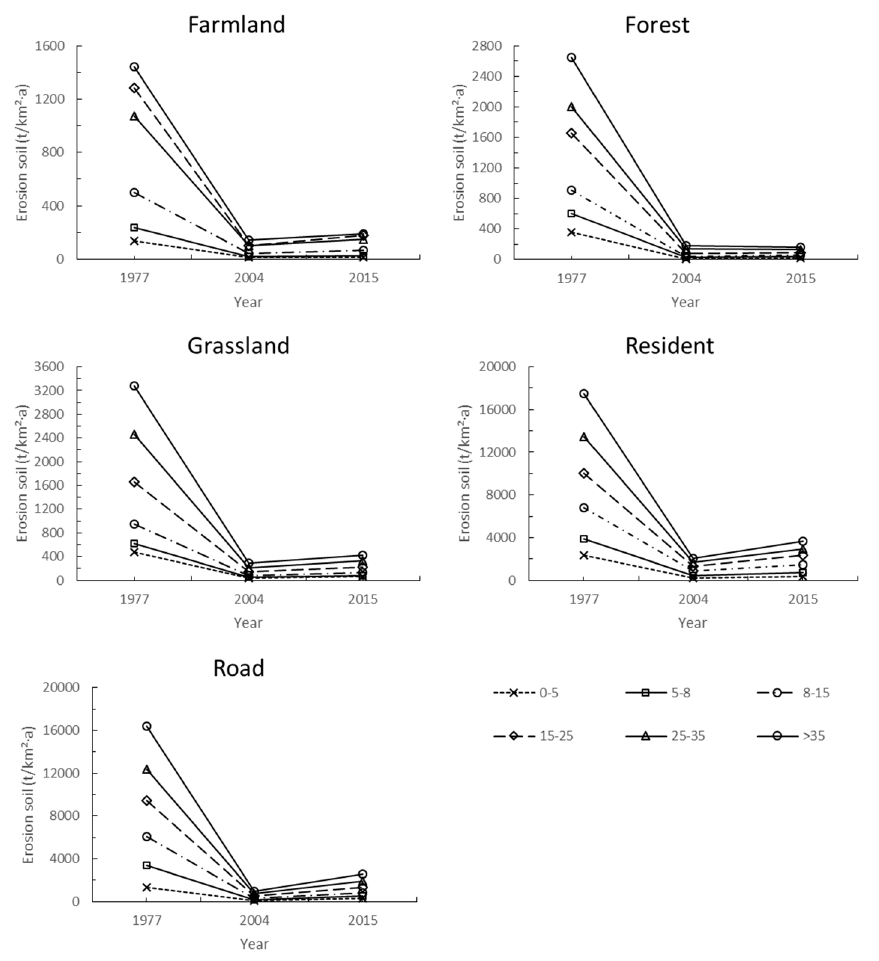
Figure 5. Soil erosion of different slope gradients under different land uses in the JYG watershed from 1977 to 2015.